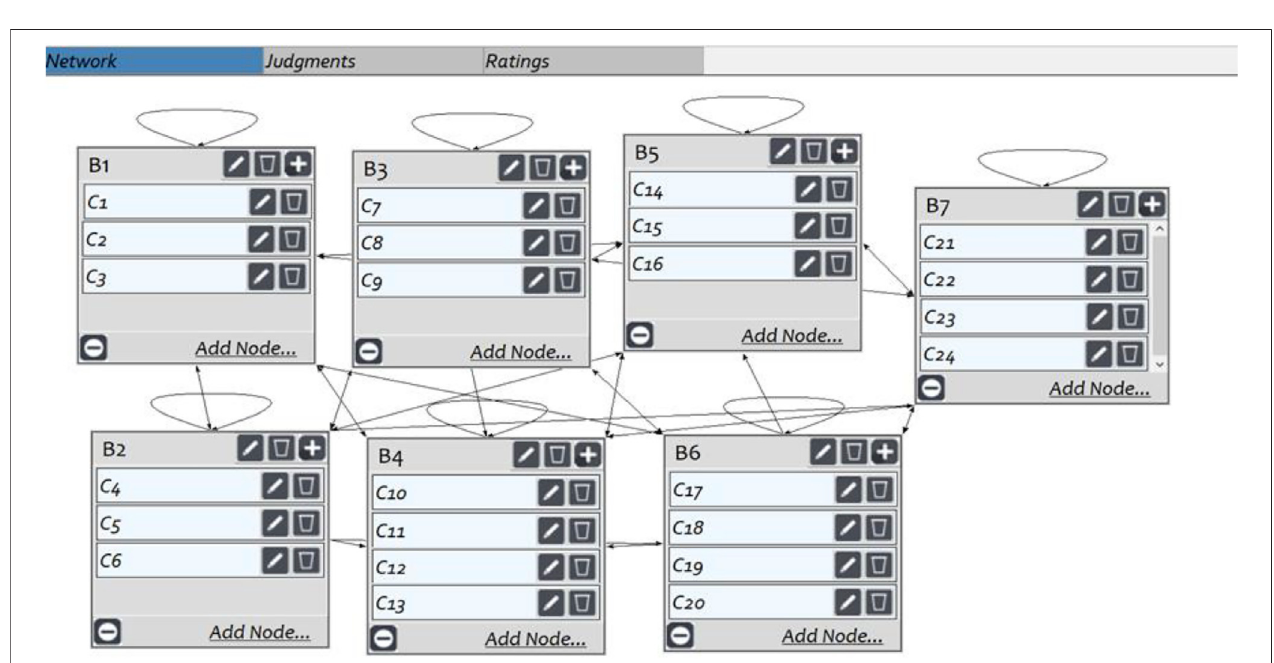
FIGURE 2 | Diagram of ANP